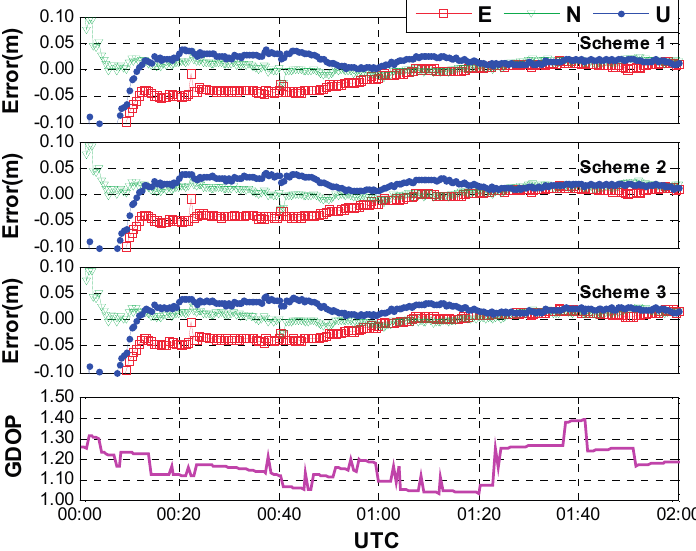
Figure 7. Positioning error and GDOP of GPS/GLONASS combined PPP with different ISB models (case one: sufficient number of GPS and GLONASS satellites, an average of 15 satellites